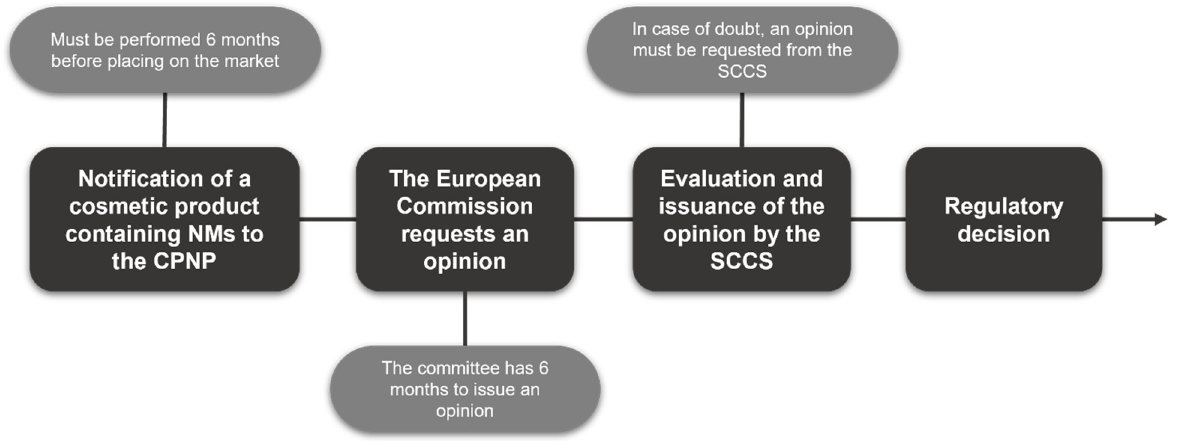
Figure 1. Cascade of processes leading to regulatory decision [5,12]. CPNP—Cosmetic Product Notification Portal; NM—Nanomaterial; SCCS—Scientific Committee on Consumer Safety.